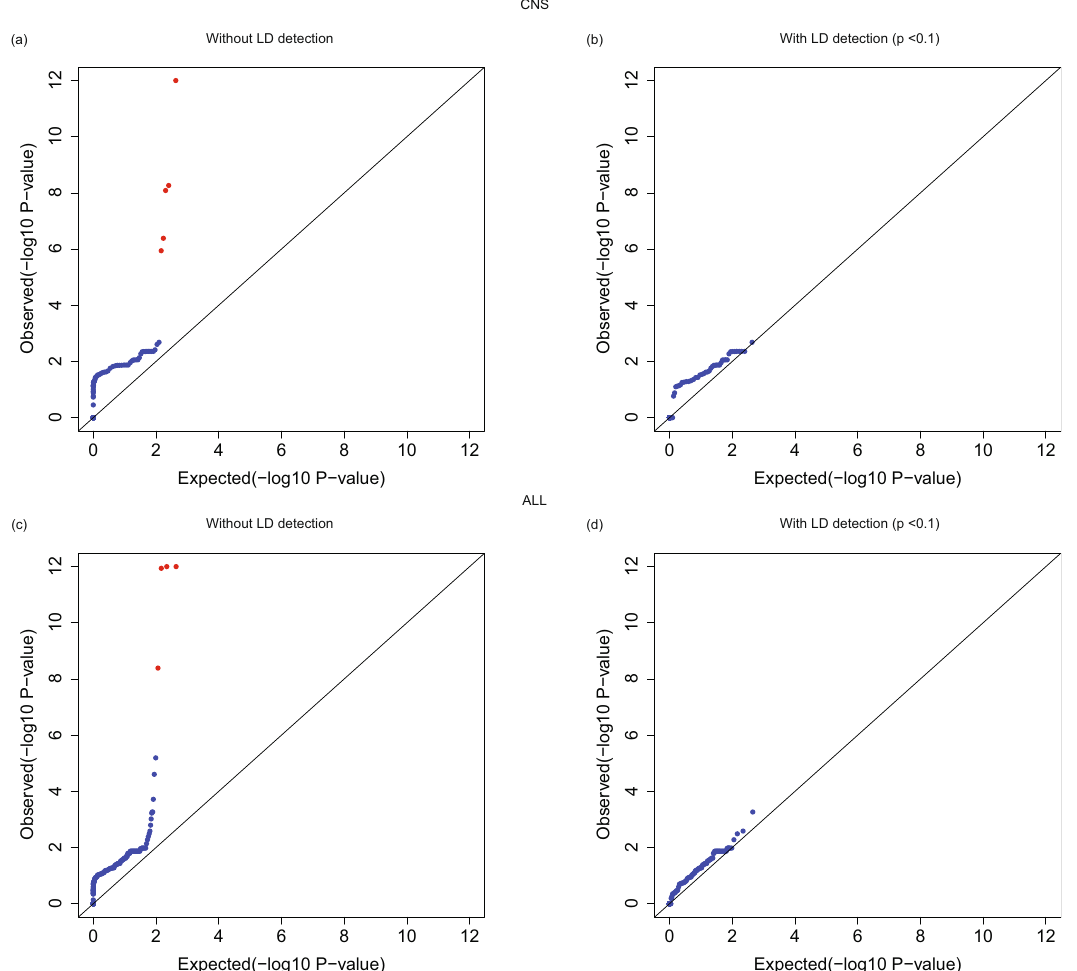
Fig. 5 Employing LD detection removes false positives under the recessive model. a , c QQ plots of association tests under the recessive model without employing LD detection in the CNS and ALL cohorts, respectively. b , d QQ plots of association tests under the recessive model after employing LD detection with a P value threshold of 0.1. Red dots in ( a ) and ( c ) are false-positive genes that pass the exome-wide signi fi cance threshold ( P < 2.5e-6). The P values are raw P values from the two-sided Cochran – Mantel – Haenszel (CMH) exact